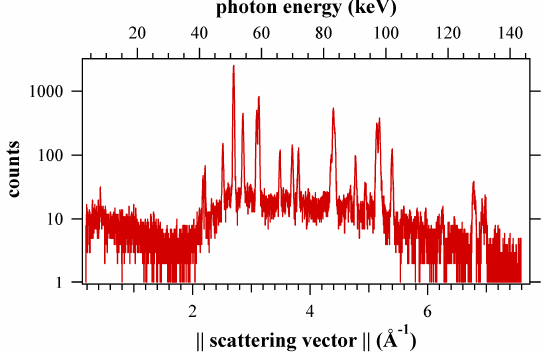
Figure 2. Full recorded detector spectrum (top axis), translating into a calibrated diffractogram (bottom axis). The bump in the background denotes the useful, transmitted energy spectrum between ~34 and 140 keV, i.e., ~1.8–7.5 Å − 1 . The data shown are the signals off the specimen at 310 K and 0 GPa.